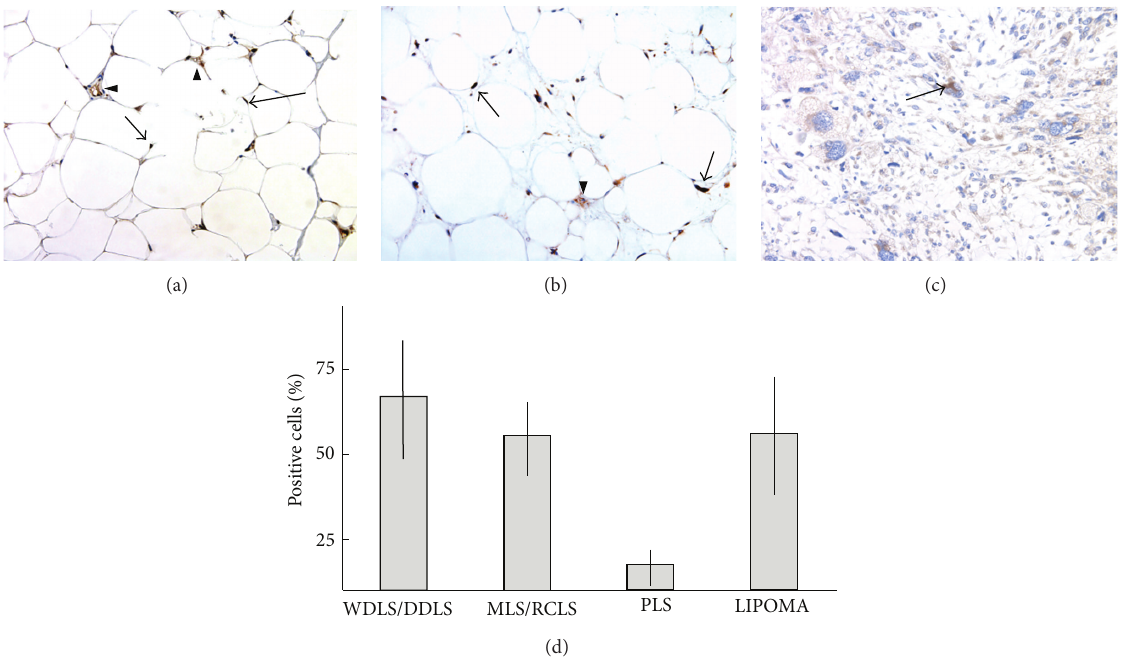
Figure 1: DDIT3 immunohistochemistry analysis of lipomatous tumors. (a) Lipoma, nuclear, and DDIT3 expression (arrow) and capillaries are indicated by arrowheads. (b) WDLS/DDLS, nuclear, and cytoplasmic DDIT3 expression (arrow). (c) PLS, nuclear, and cytoplasmic DDIT3 expression in lipoblasts (arrow). (d) Mean value and standard deviation of percent positively stained cells in 10 cases of WDLS/DDLS, 16 cases of MLS/RCLS, 11 cases of PLS, and 11 cases of